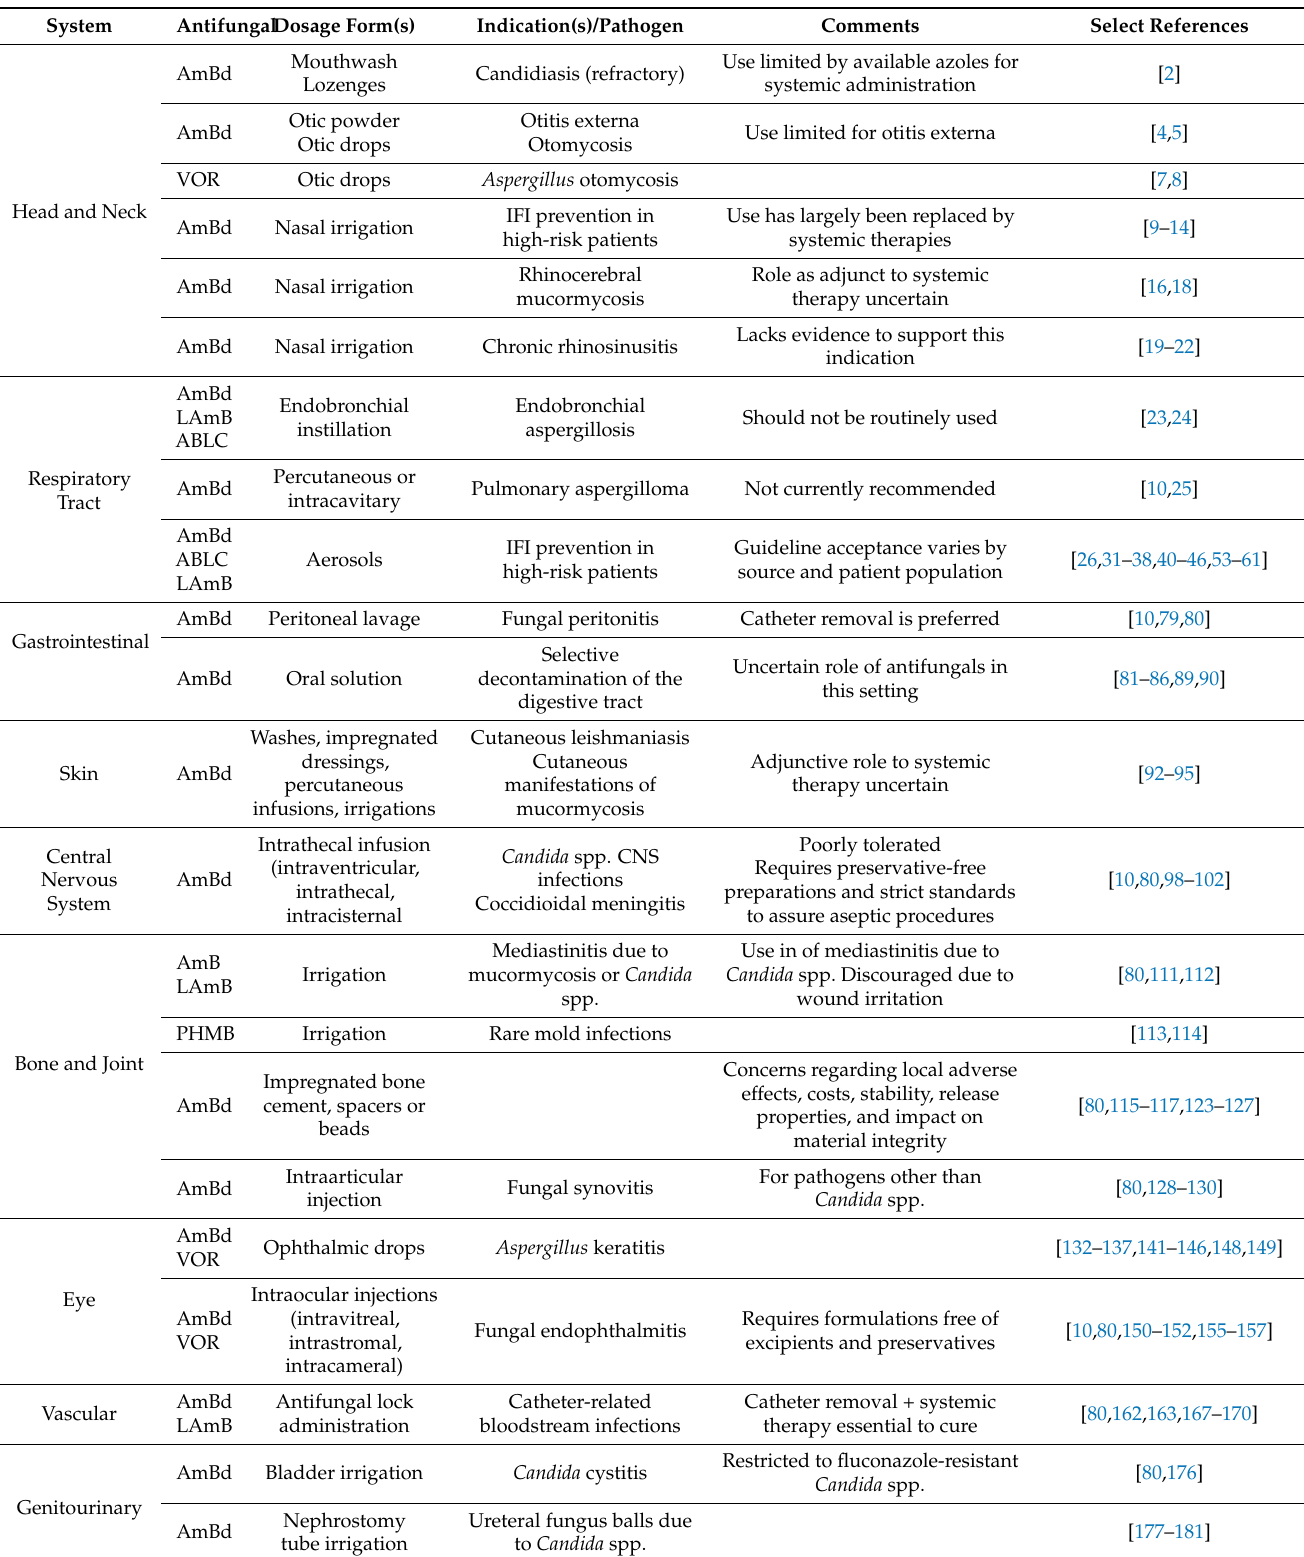
Table 1. Summary of unconventional* application of antifungals for invasive fungal